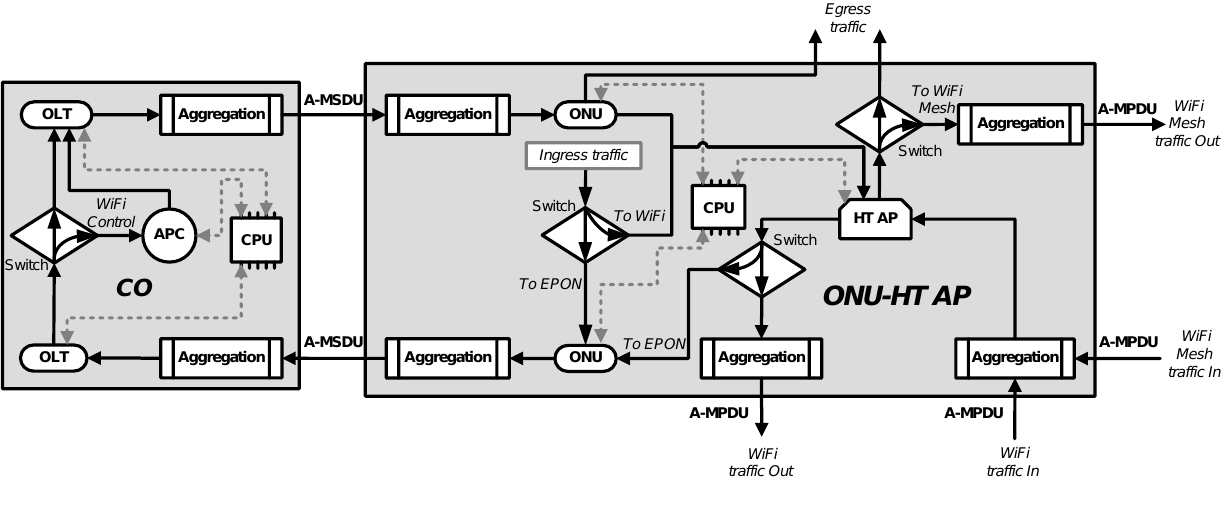
Figure 9. Functional block diagram of CO and ONU-HT